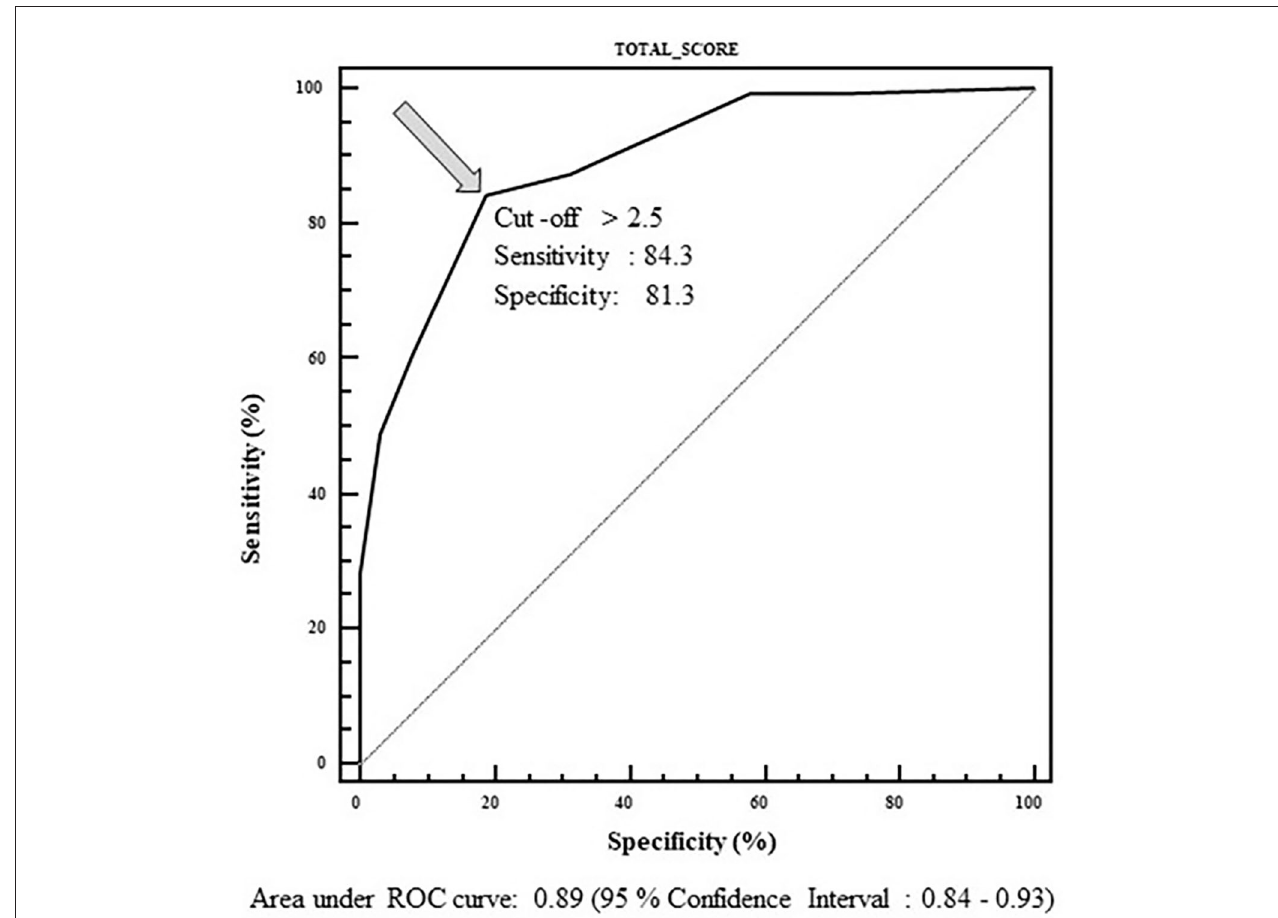
FIGURE 1 | ROC curve used to determine cut-off value of the total score able to predict surgical intervention. Range of the score: 0–8.5. Best cut-off value: